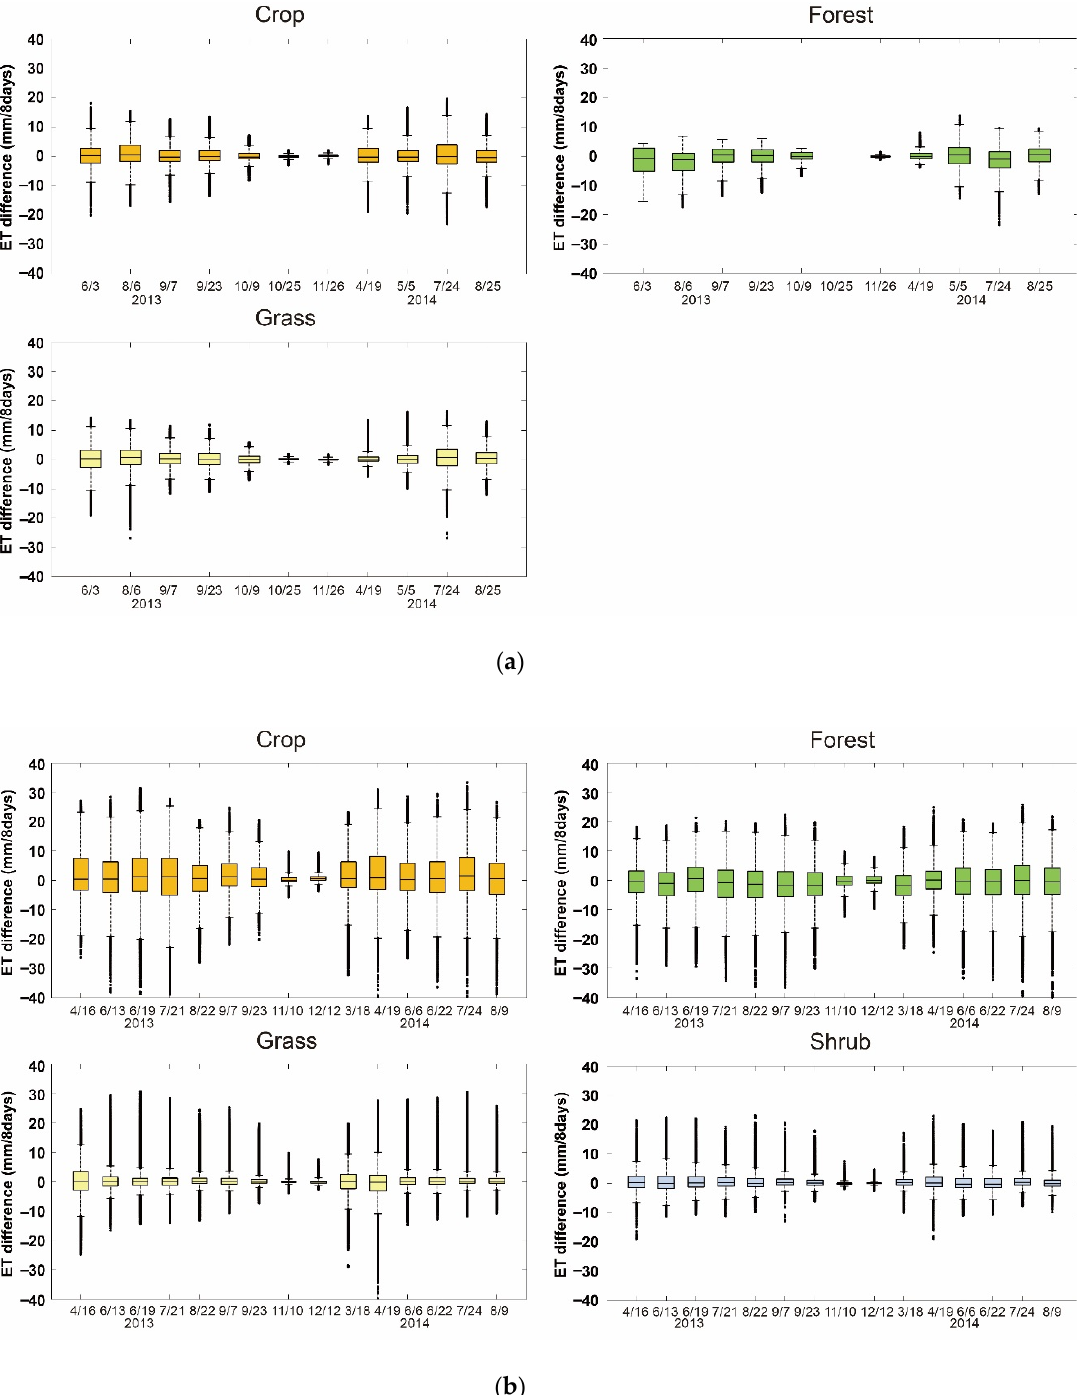
Figure 10. Figure 10. Cont.